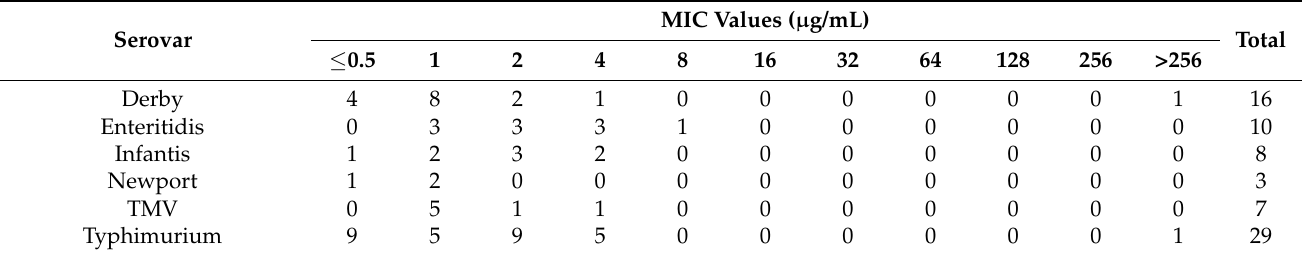
Table 5. Minimum inhibitory concentration (MIC) values obtained for Salmonella serovars most frequently detected in human infections in EU between 2015 and